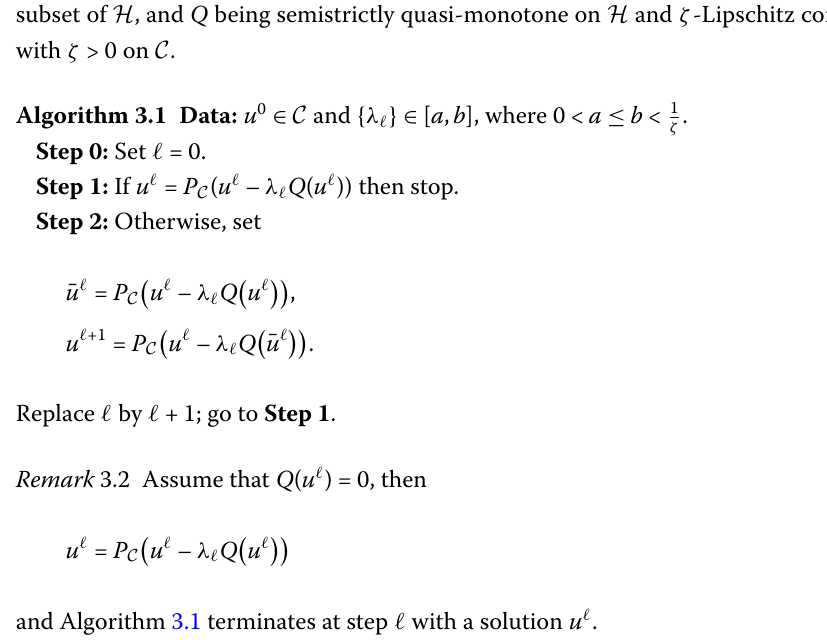
Algorithm 3.1 Data: u 0 ∈ C and { λ (cid:6) } ∈ [ a , b ], where 0 < a ≤ b < 1